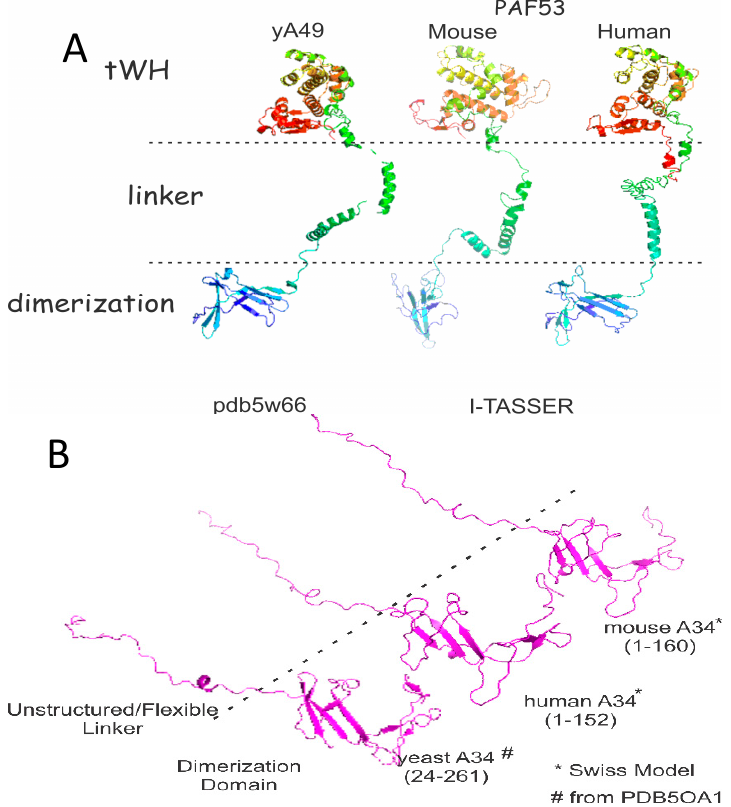
Figure 1. Predicted structural similarities of the A49 orthologs ( A ) and the A34 orthologs ( B ).